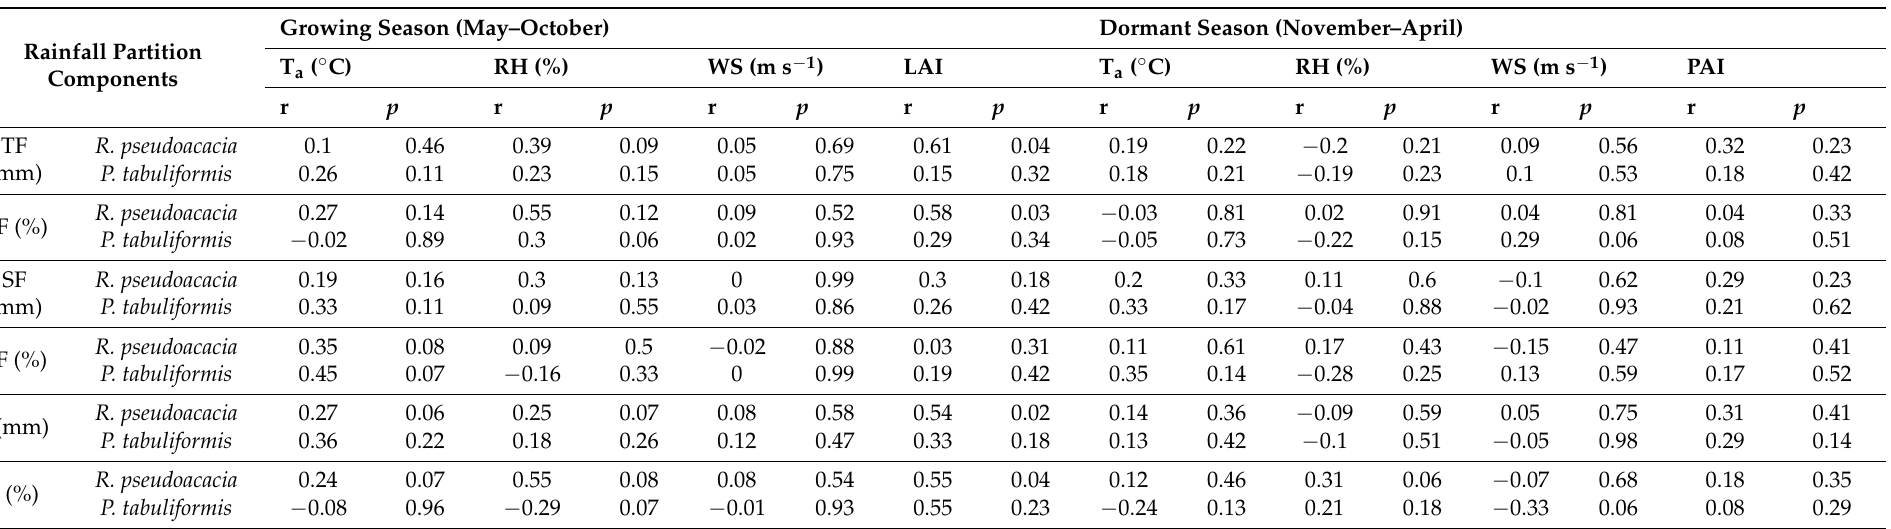
Table 2. Correlations between meteorological variables, leaf/plant area index (LAI/PAI, cm 2 cm − 2 ) and rainfall partitioning components for R. pseudoacacia and P. tabuliformis forest stands during the growing and dormant seasons in 2015 and